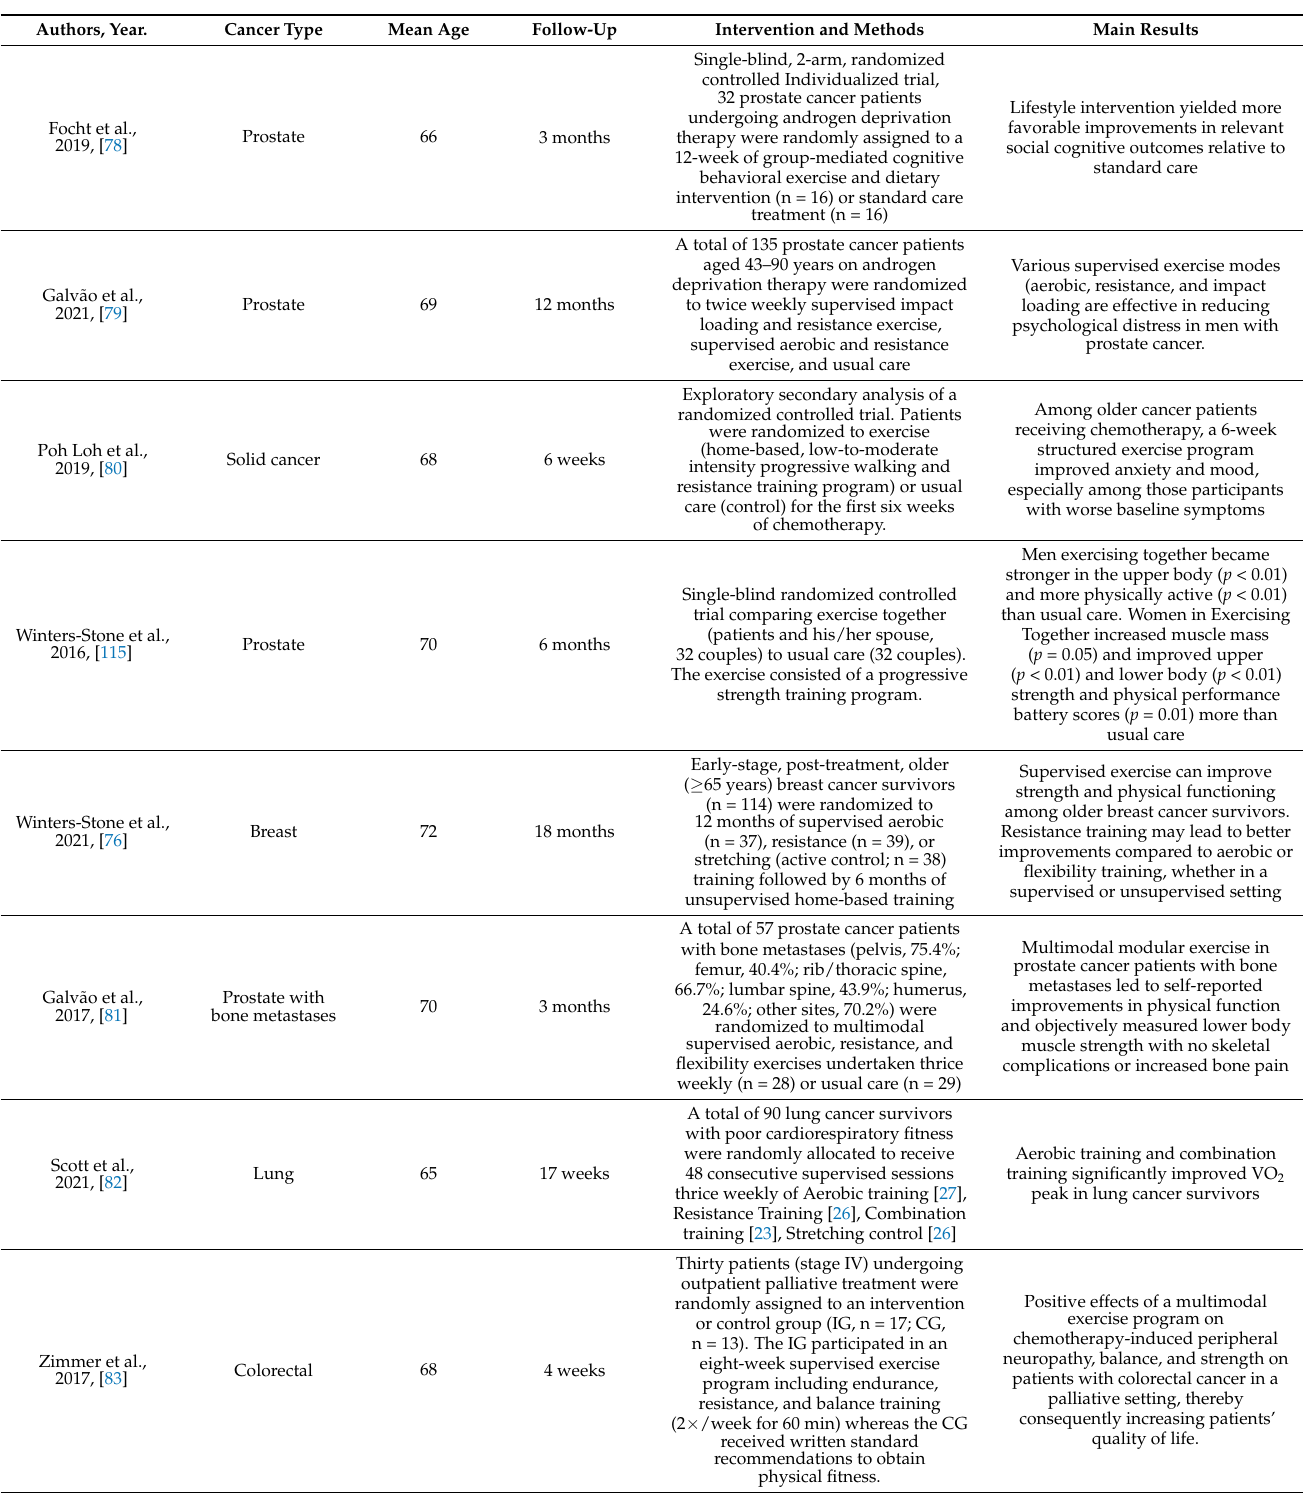
Table 2. Main characteristics and results of randomized controlled trials evaluating oncological rehabilitation in the elderly